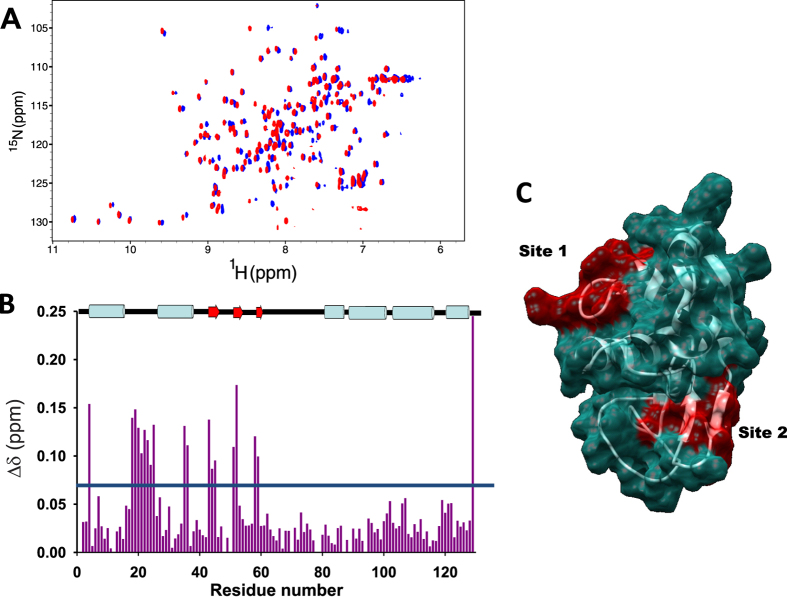
Nuclear magnetic resonance study of the solution interaction between HEWL and 2 m-3HP.(A) Overlapping of the overall 15N-HSQC spectra of HEWL at pH 2.0 and 37 °C acquired in the absence (red) or in the presence of 2 m-3HP (blue) at a HEWL:2 m-3HP ratio of 1:5. (B) Chemical shift histogram of the weighted amide chemical shift perturbation observed along the HEWL sequence after addition of 2 m-3HP at a HEWL:2 m-3HP ratio of 1:5. The secondary structure is indicated on the plot as reference. (C) Cartoon representation of the HEWL structure and its surface generated using PyMOL and the crystal structure with the PDB code 1LSE. Amino acids whose resonances were affected by the presence of 2m-3HP (above the blue line in panel B; Δδave > 0.07 ppm) are coloured in red.